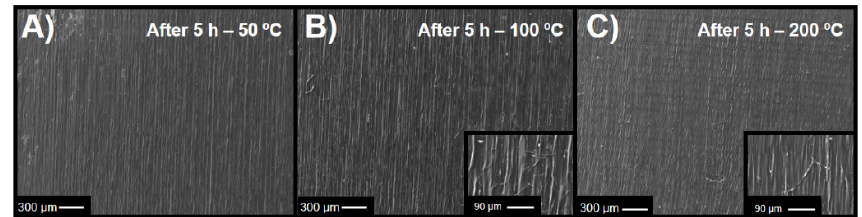
Figure 7. Micrographs of the plates submitted to different thermal treatments under oxidant condi- tions: ( A ) 5 h–50 °C; ( B ) 5h–100 °C; ( C ) 5 h–20 °C.